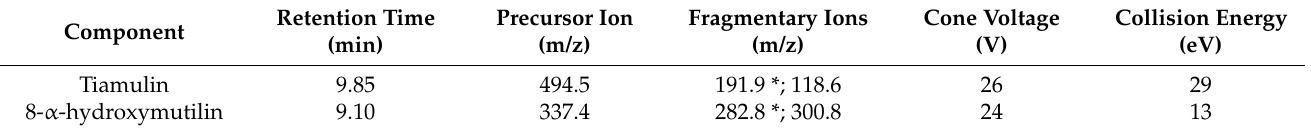
Table 8. Retention time and MS/MS parameters for tiamulin hydrogen fumarate and 8- α